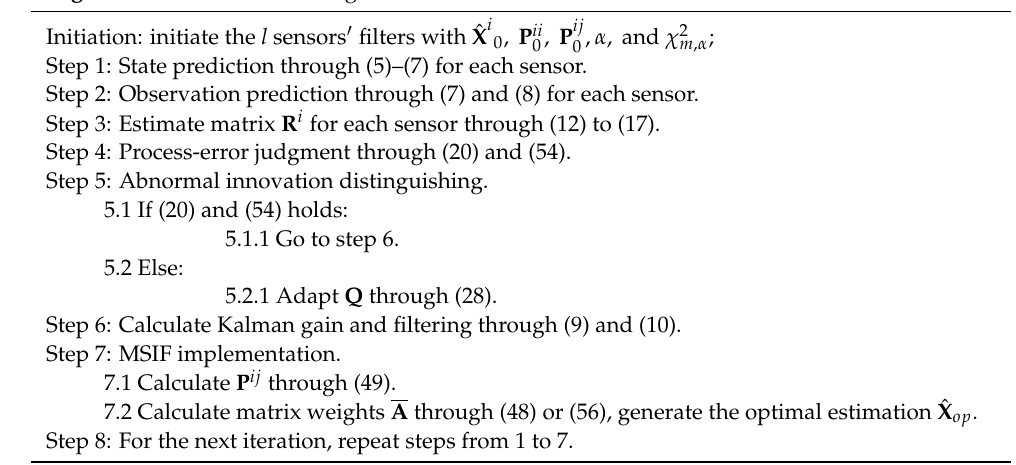
Algorithm 1. ARUKF-MSIF algorithm